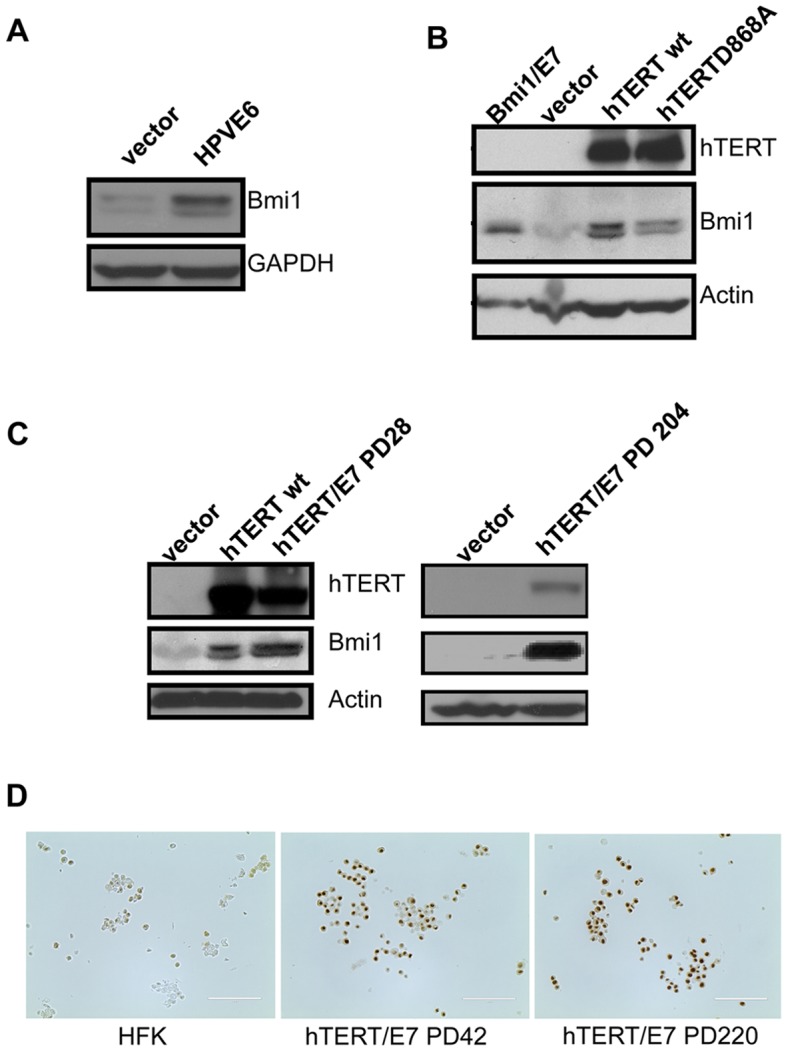
Bmi1 protein increases in cell lines.Bmi1 protein levels were quantified by Western blot for (A) empty vector and E6 expressing cells and (B) hTERTwt or hTERT-D868A expressing cells. Bmi1+E7 lysate served as a positive control for Bmi1 protein. Lysates were separated by 4–20% gradient SDS-PAGE. Antibodies were used to detect hTERT (1∶1000, Origene) and Bmi1 (1∶200, F6, Millipore), normalized to GAPDH (1∶2000, FL-335, Santa Cruz) or ACTIN (1∶5000, Sigma). (C) Bmi1 protein levels were quantified by Western blot. Long-term serial passaging maintains increased levels of Bmi1 protein, as shown by the P102 hTERT+E7 lysate. Lysates were separated by 4–20% gradient SDS-PAGE. Antibodies were used to detect hTERT (1∶1000, Origene), Bmi1 (1∶200, F6, Millipore) and actin (1∶5000, Sigma). (D) Cell pellets were formalin fixed and paraffin embedded. Bmi1 protein levels were assayed by immunocytochemistry (1∶200, F6, Millipore). The images were captured with the Evos LX microscope. Scale bar = 100 µm.